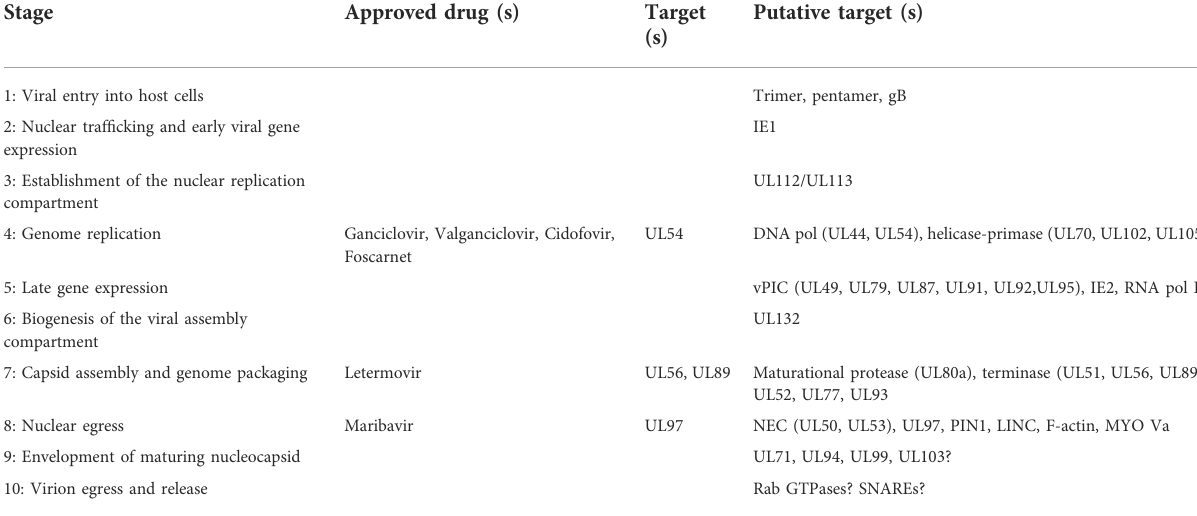
TABLE 1 Summary of approved HCMV antivirals and putative targets for future antiviral development.